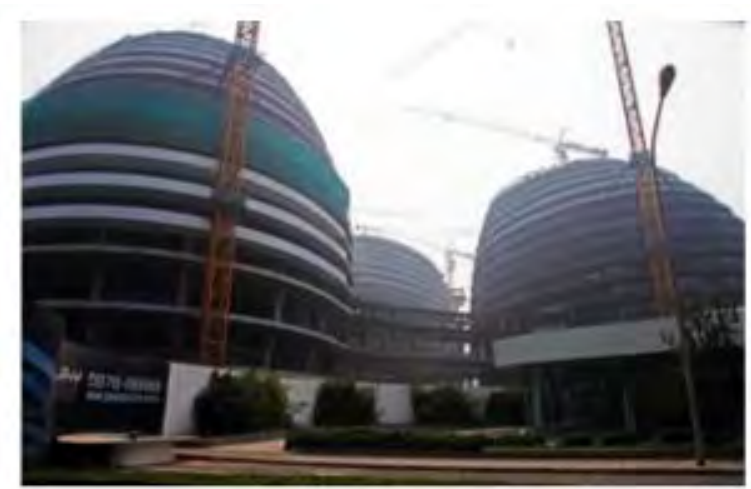
Figure 18. Galaxy Soho. Zaha Hadid: Soho Galaxy in Process, design